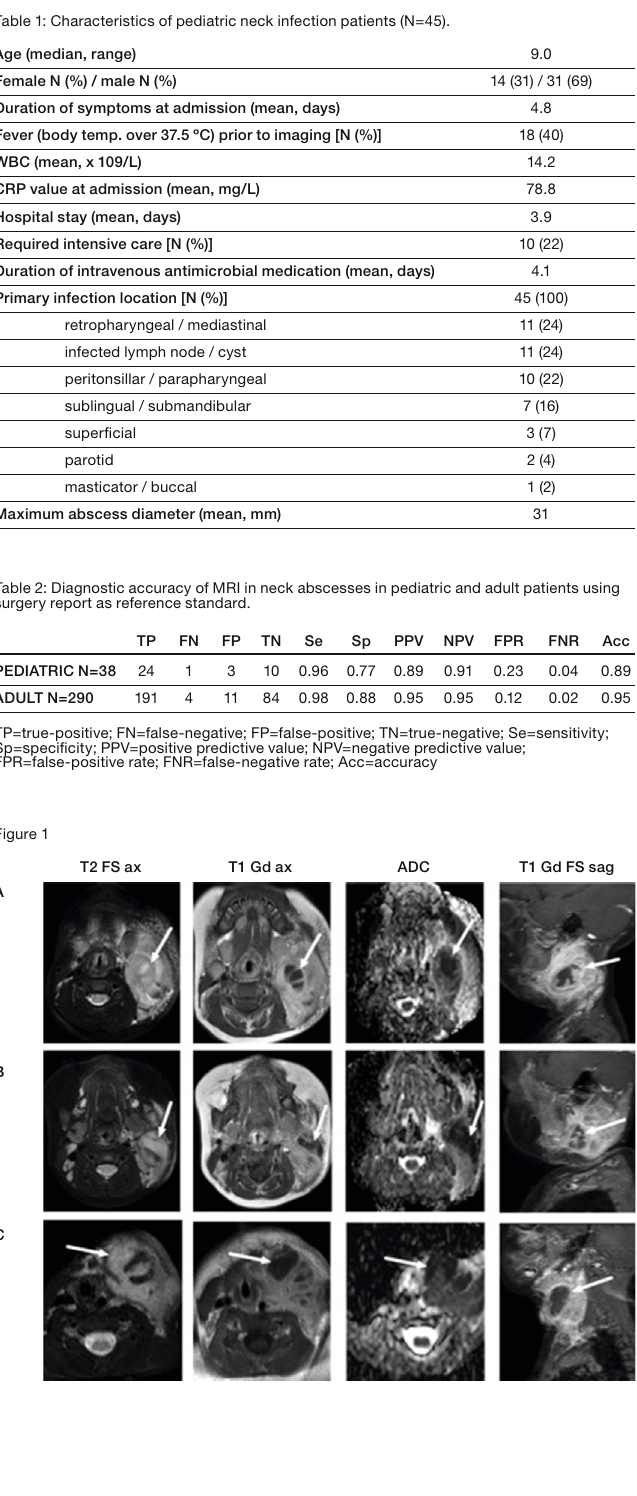
Table 1: Characteristics of pediatric neck infection patients (N=45).